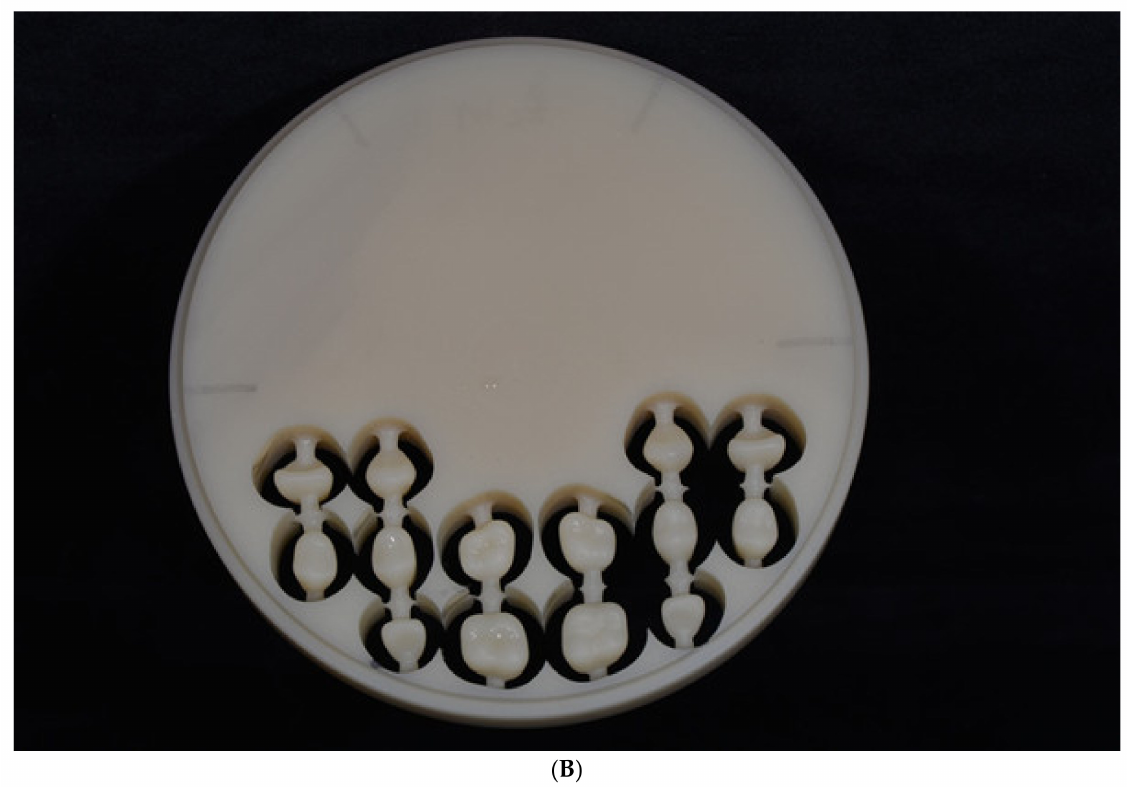
Figure 6. ( A ): Milled denture base. ( B ): Milled artificial